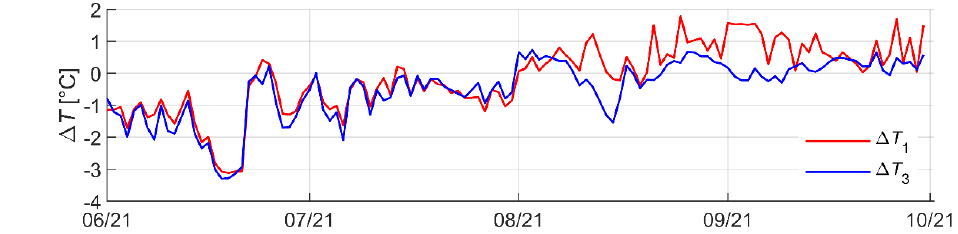
Figure 6. Difference of daily mean plant surface temperature and ambient air temperature